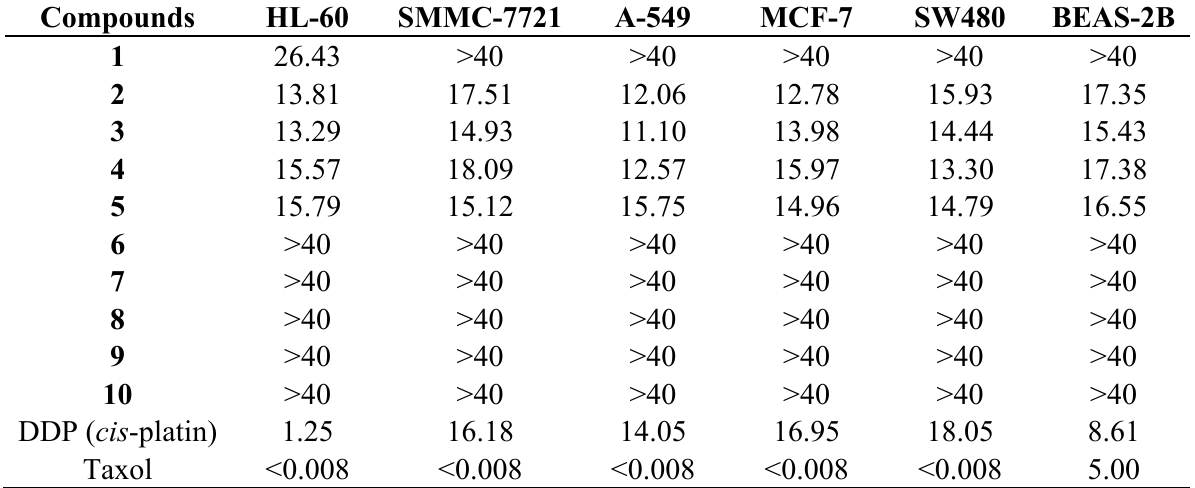
Table 2. IC Values ( μ M) of Compounds 1 – 10 against Five Human Cancer Cell Lines and 50 One Human Normal Cell